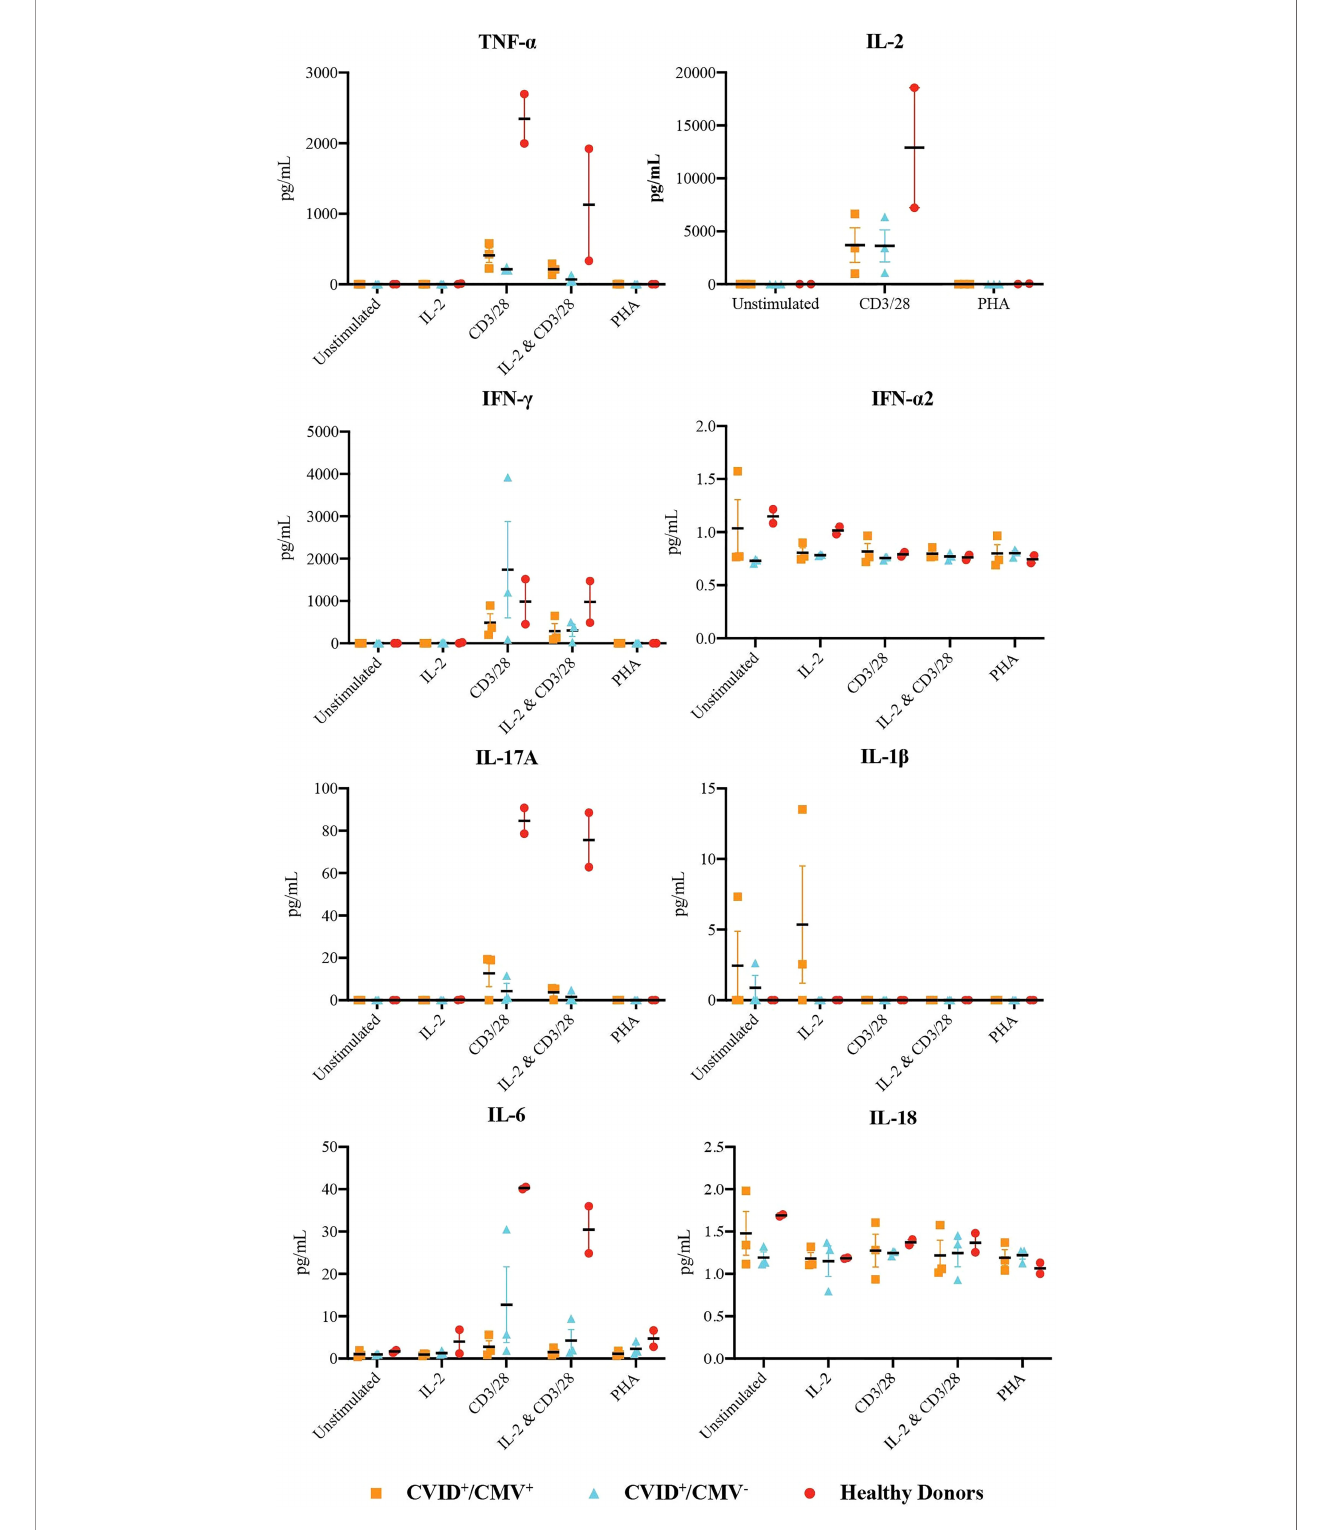
FIGURE 2 | Production of in fl ammatory cytokines by T-cells. Concentrations of TNF- a , IL-2, IFN- g , IFN- a 2, IL-17A, IL-1b, IL-6 and IL-1 in the supernatant of proliferating T-cells at 48 hours, under all stimulation conditions. Results presented as individual values, means and standard errors of the